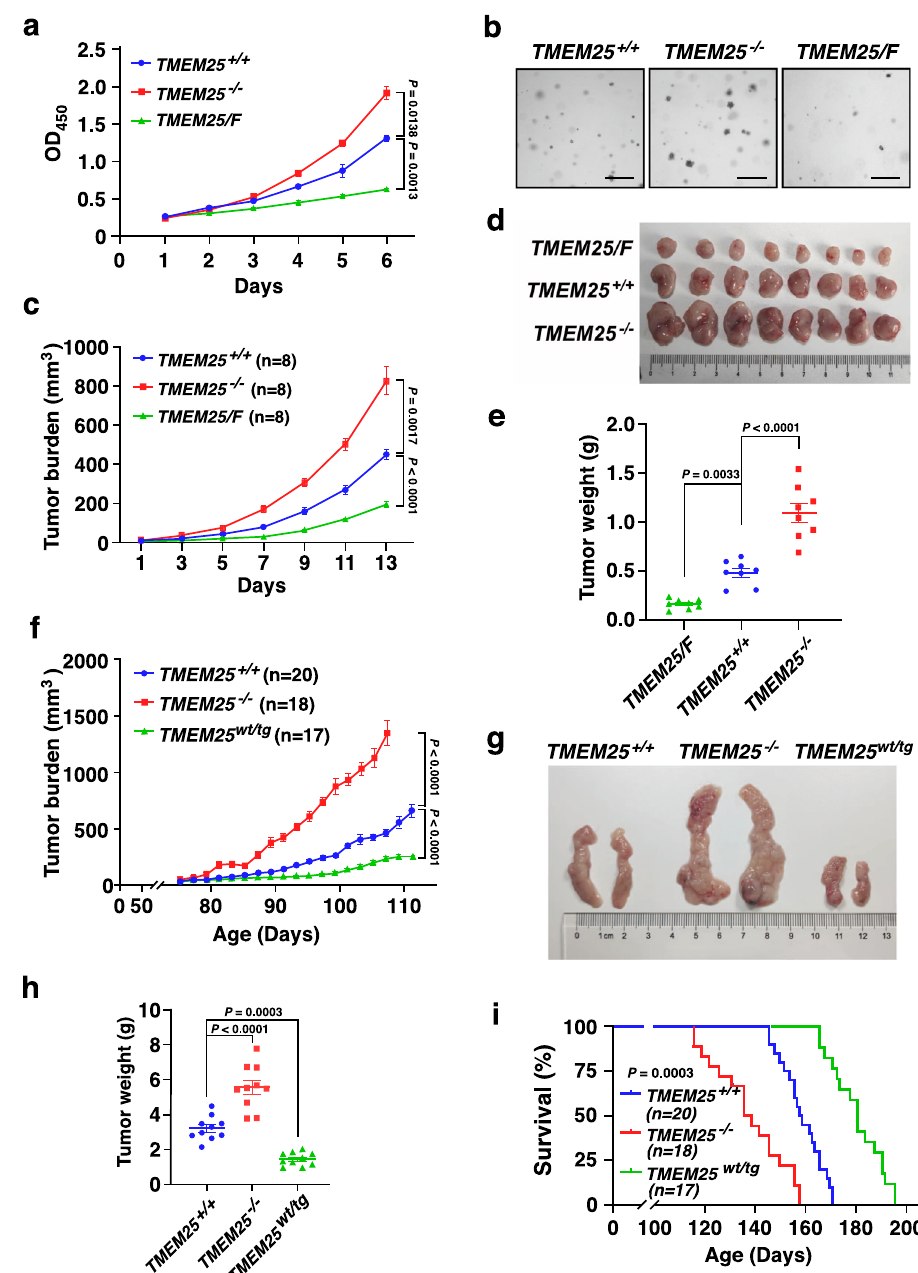
Fig. 2 | TMEM25 inhibits TNBC progression. a Effect of TMEM25 on growth of MDA-MB-231 cells. Cell viability of wild-type ( TMEM25 +/+ ), TMEM25 knockout ( TMEM25 − / − ), and Flag-tagged TMEM25 overexpressing ( TMEM25/F ) MDA-MB-231 cells were determined using CCK-8 assay. Data were presented as mean±SEM of three individual experiments. P values were determined by two-way ANOVA fol- lowedbyTukeytest. b EffectofTMEM25oncolonyformationofMDA-MB-231cells. TMEM25 +/+ , TMEM25 − / − , and TMEM25/F MDA-MB-231 cells were subjected to soft agar assay. Scale bar indicates 100 μ m. At least three biological replicates were performedforeachcondition. c – e TMEM25suppressesxenografttumorgrowthof MDA-MB-231cellsinnudemice. TMEM25 +/+ , TMEM25 − / − ,or TMEM25/F MDA-MB-231 cells were orthotopically injected into the mammary fat pad of nude mice to observe tumor formation. Tumor volumes were measured and plotted as mean± SEM ( n =8 animals per group). P values were determined by two-way ANOVA fol- lowed by Tukey test ( c ). The tumors were obtained 13 days after tumor formation by sacri fi cing the mice ( d ), weighted and plotted as mean±SEM ( n =8 animals per